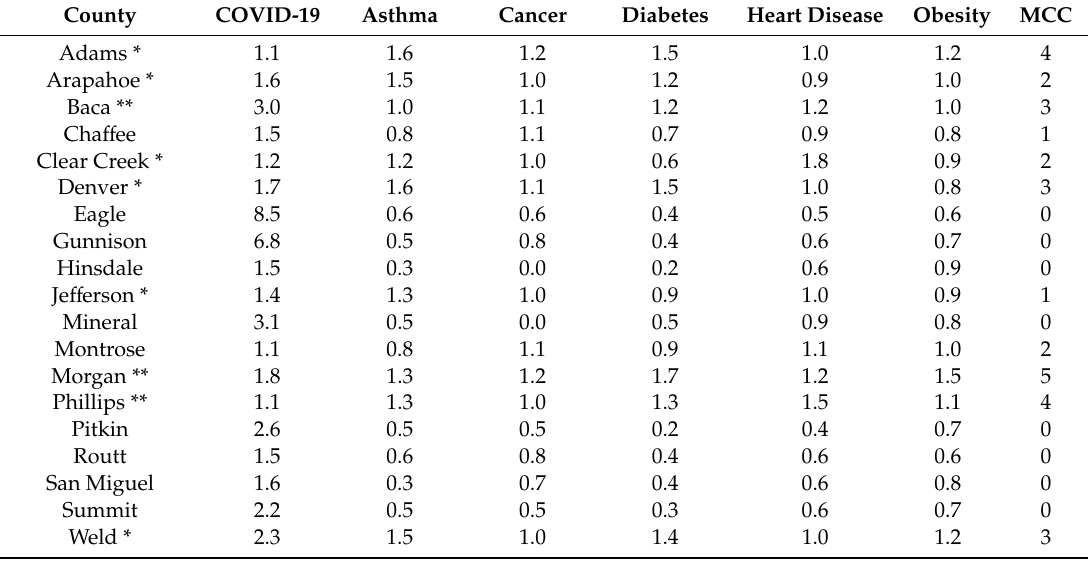
Table 7. Rate ratio (number of times above the state average) comparison of COVID-19 incidence rates and multiple chronic conditions in